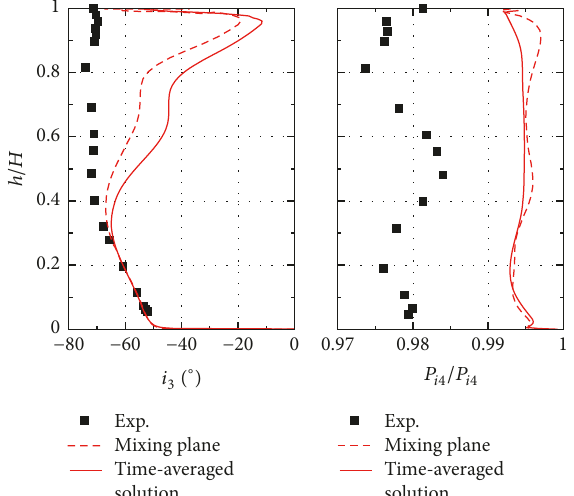
Figure 6: Experimental and numerical stator incidence and losses.